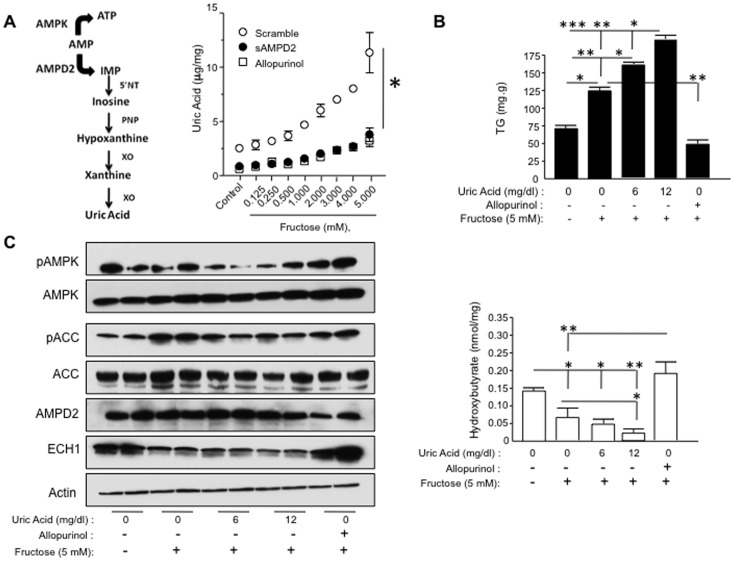
Uric acid negatively regulates AMPK activity.A) Schematic representation of downstream metabolites produced from AMP by AMPD2. Right, uric acid levels –the final product of this route- are increased in HepG2 cells exposed to fructose in a dose-dependent manner. Both inhibiting xanthine oxidase activity with allopurinol or silencing AMPD2 significantly inhibits uric acid generation. *p<0.05. B) Uric acid further increases fructose-induced triglyceride accumulation (top) and decreases β- hydroxybutyrate levels (bottom) in a dose-dependent manner while allopurinol blocks it. *p<0.05, **p<0.01, ***p<0.001 C) Representative western blot demonstrating that uric acid inhibits fructose-mediated activation of AMPK with significantly lower ACC phosphorylation at ser79 and ECH1 levels in a dose-dependent manner. In contrast, allopurinol (100 µM) further increases the activation of AMPK with significantly higher ACC phosphorylation at ser79 and ECH1 levels.